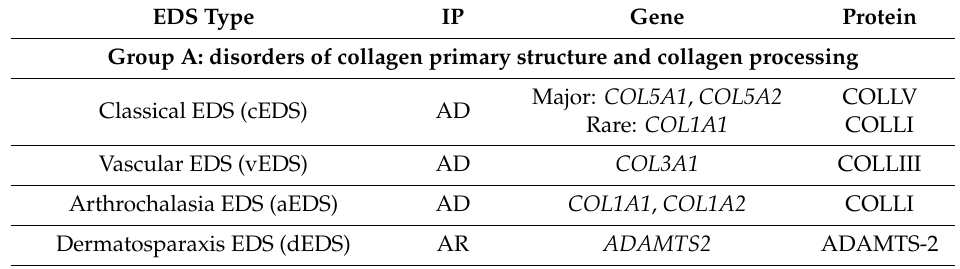
Table 1. EDS types grouped according to the underlying genetic defect and